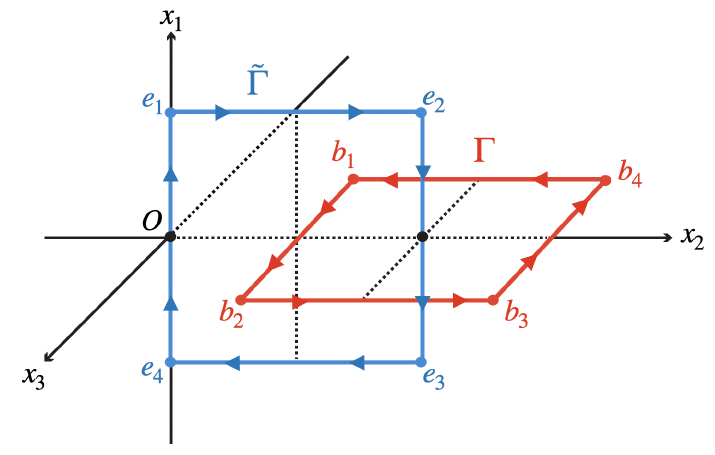
Figure 6 . Regions S and ˜ S delimited by Γ and ˜Γ for e = x 3 = 0 and b = y 1 = 0